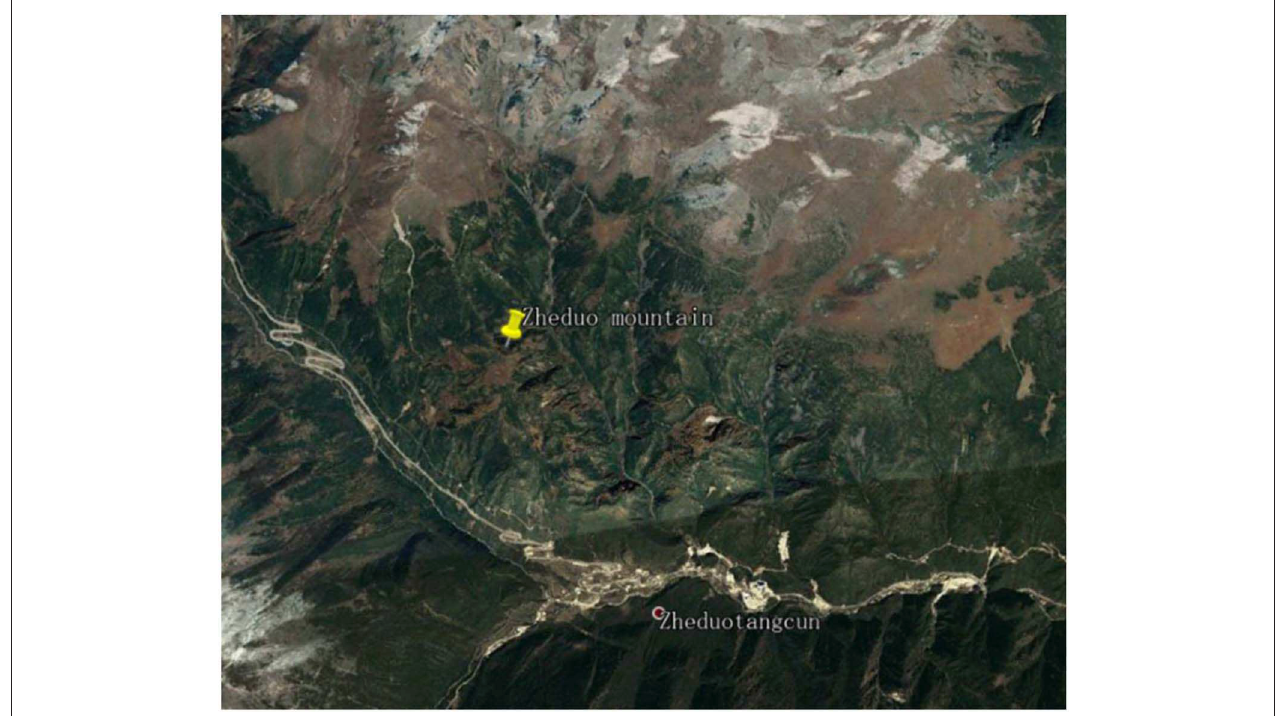
FIGURE 1 | Satellite image of Zheduo